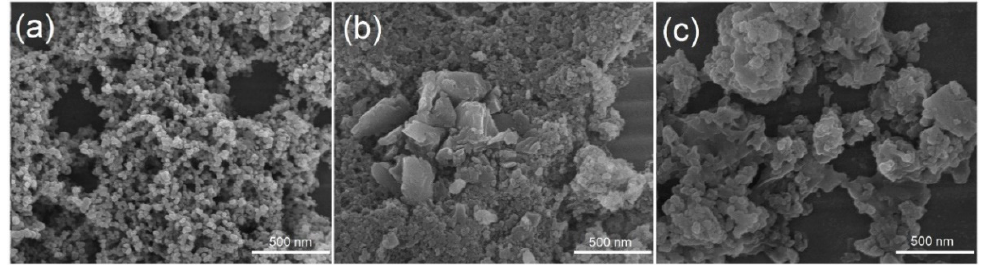
Figure 3. The FE-SEM images of 1 ( a ), 2 ( b ), and 3 ( c